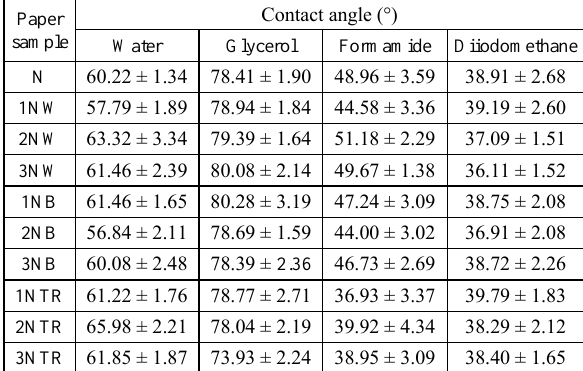
Table 4. Topographical parameters of laboratory-made papers Paper sample